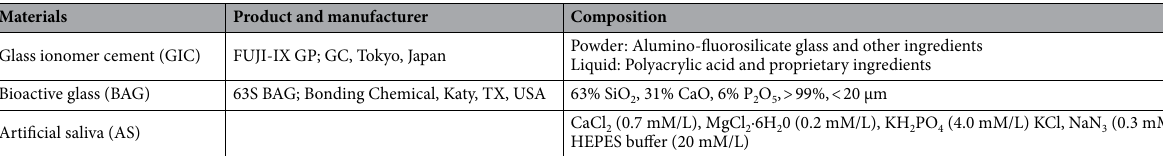
Table 1. Composition of materials used in this study.